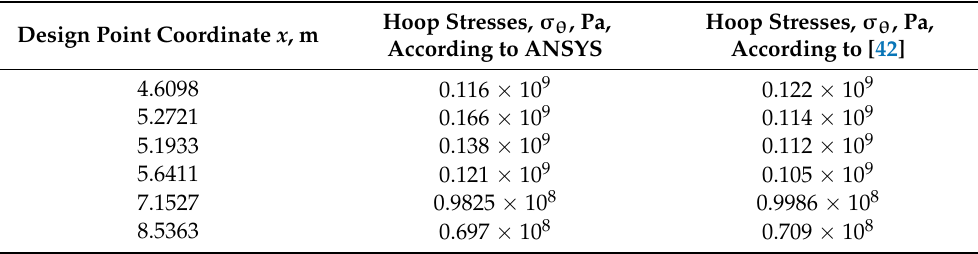
Table 4. The results of calculating the hoop stresses, σ θ , in the tank wall using the ANSYS software package and according to